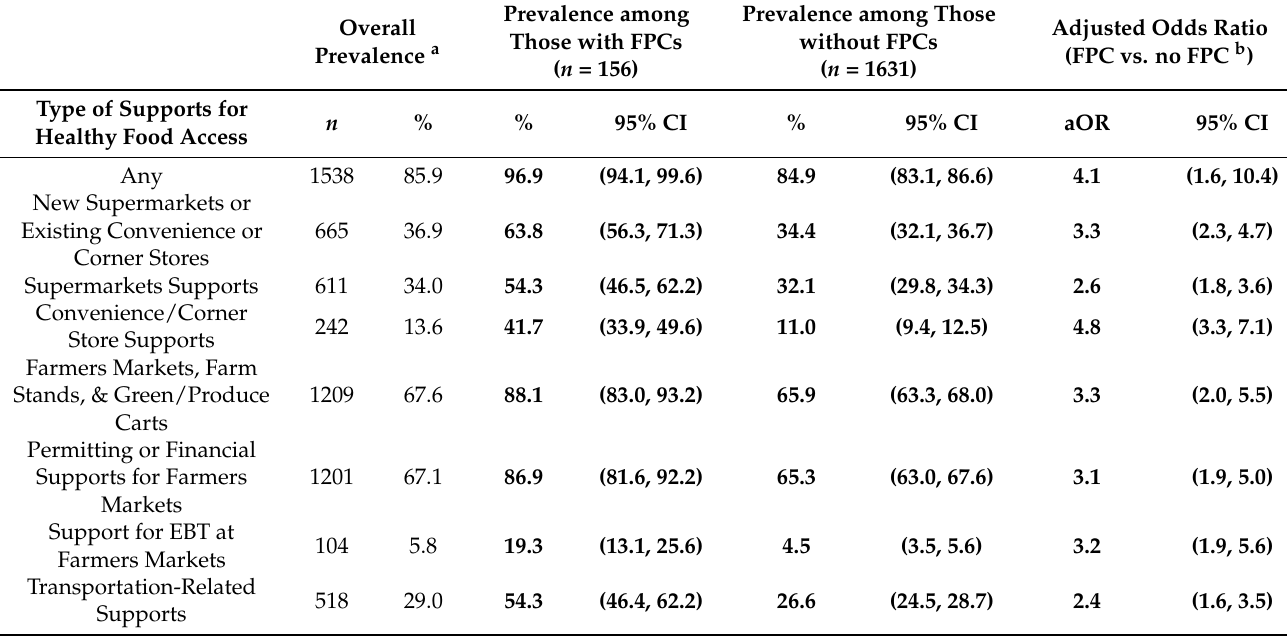
Table 3. Prevalence, 95% confidence intervals, and adjusted odds ratios of reported policies or practices to improve access to healthy foods in municipalities with and without local or regional food policy councils (FPCs), National Survey of Community-Based Policy and Environmental Supports for Healthy Eating and Active Living, United States,